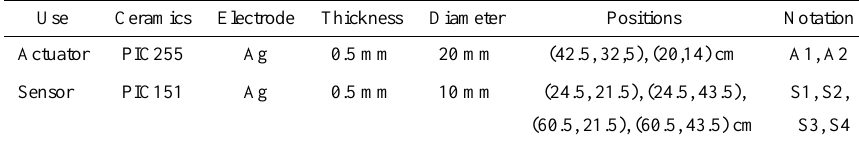
Properties and position of